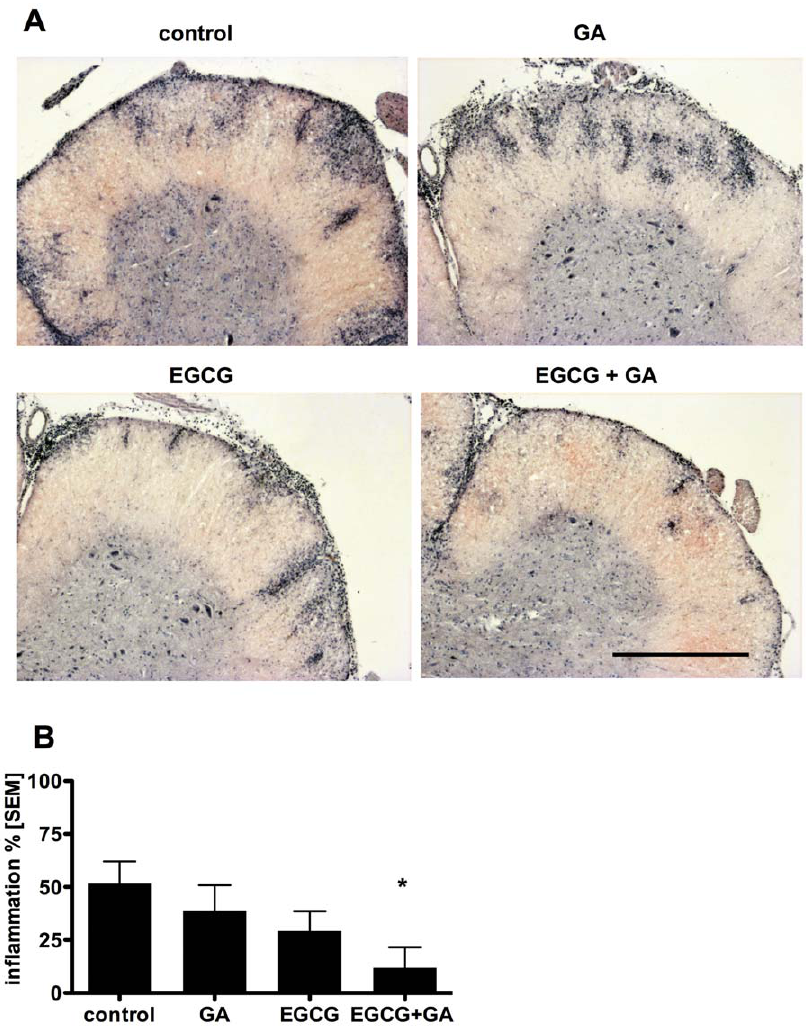
Figure 5. EGCG and GA together ameliorate CNS inflammatory pathology. Representative Hematoxylin and Eosin staining of transverse spinal cord sections of vehicle, EGCG, GA and EGCG and GA treated EAE mice is shown (A). 100 6 magnification, scale bar 500 m m. Inflammation in standardized areas of the spinal cord of all treatment groups was assessed and is presented semi-quantitatively as percentage of spinal cord quadrants with inflammatory foci relative to all assessed quadrants (B), *p , 0.05, n=8 per